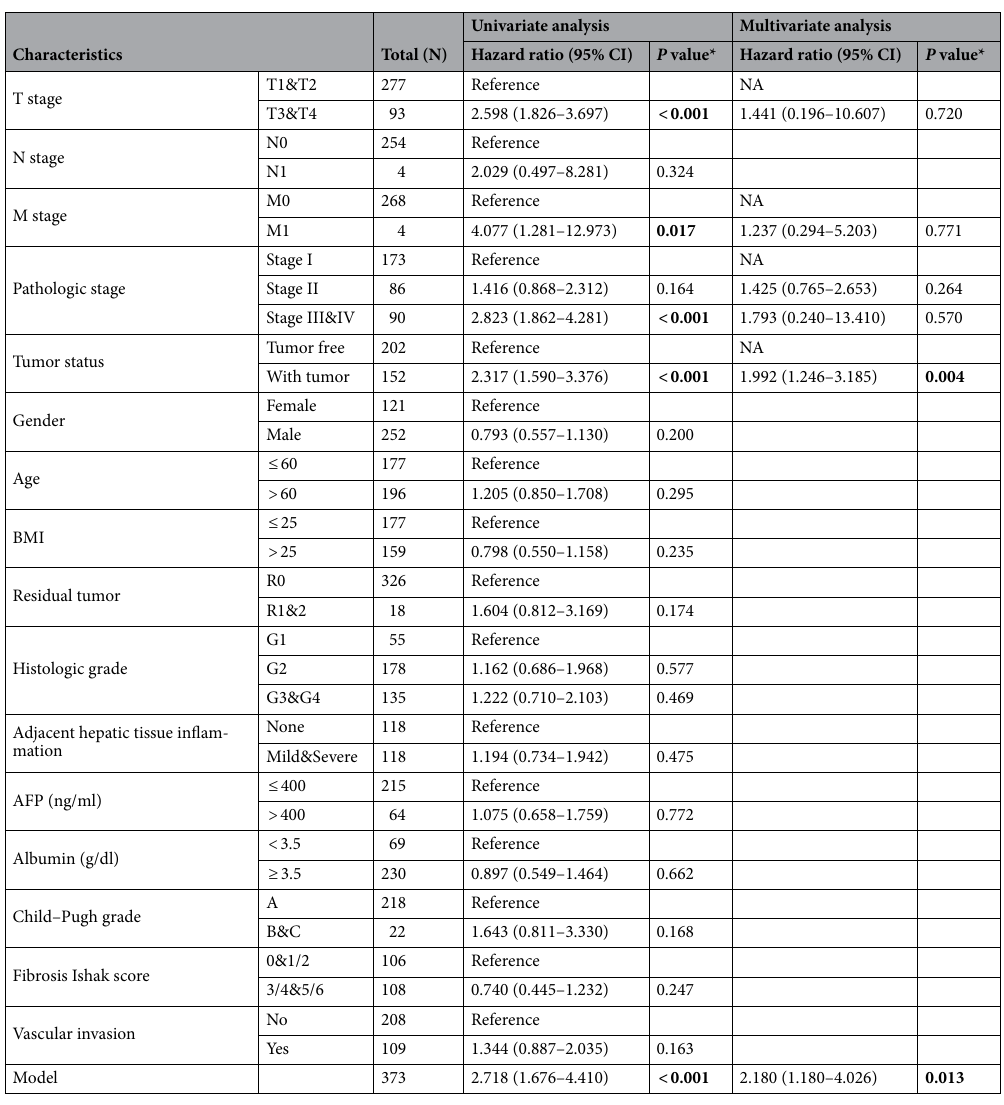
Table 5. The univariate and multivariate analysis for the OS (TCGA-LIHC). OS overall survival, CI confidence interval, NA reference group or could not be evaluated. *Compared with each group (log-rank test or omnibus test for univariate, Cox regression analysis with adjusted hazard for multivariate). p < 0.05 means statistically significant (highlighted in